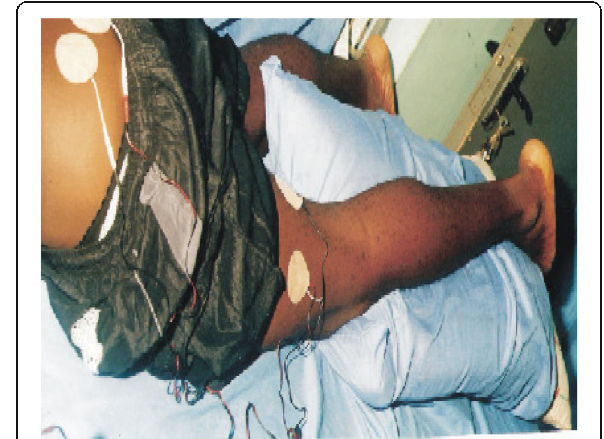
Fig. 3 Showing the third tens electrode placement. This positioning also lasted 20 min. By this, the total treatment per session was 60 min for each